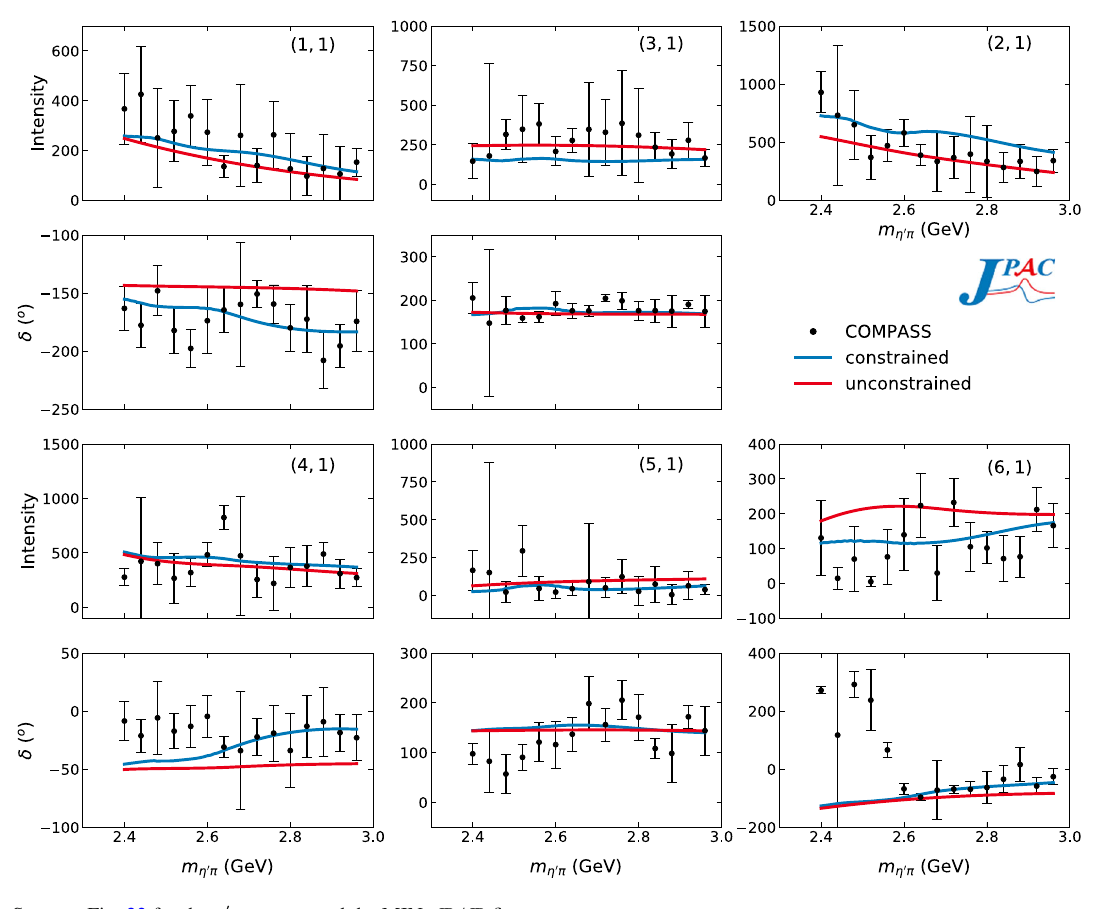
Fig. 24 Same as Fig. 23 for the η (cid:2) π system and the MIN+ IP / IP fit